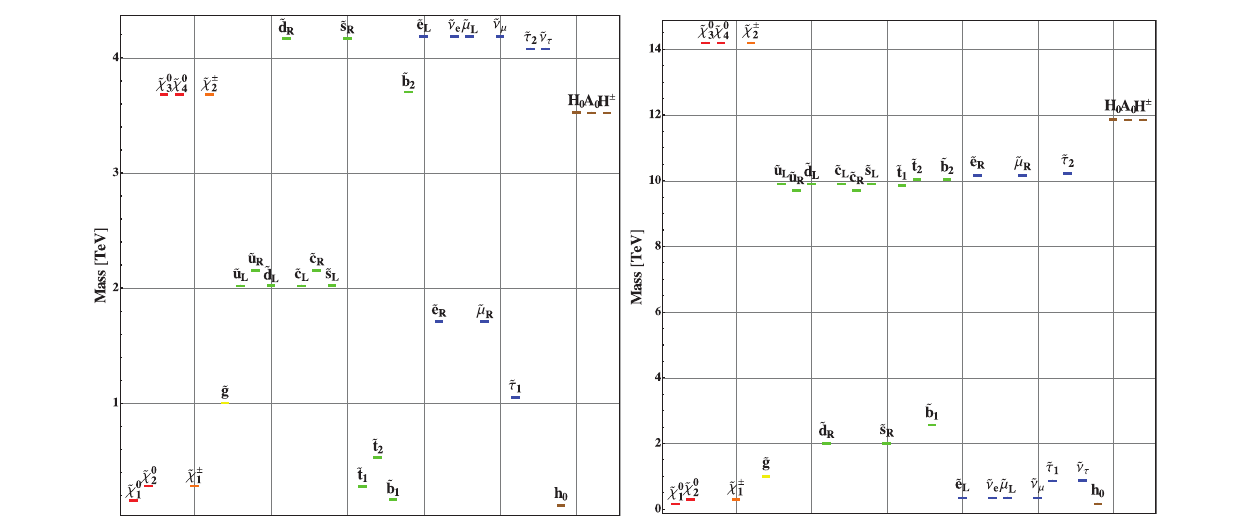
FIGURE 10 | Supersymmetric particle spectra in two example scenarios with large SO(10) D-terms based on Equation (22) with m 2 (light third generation, left) and based on Equation (24) with m 2